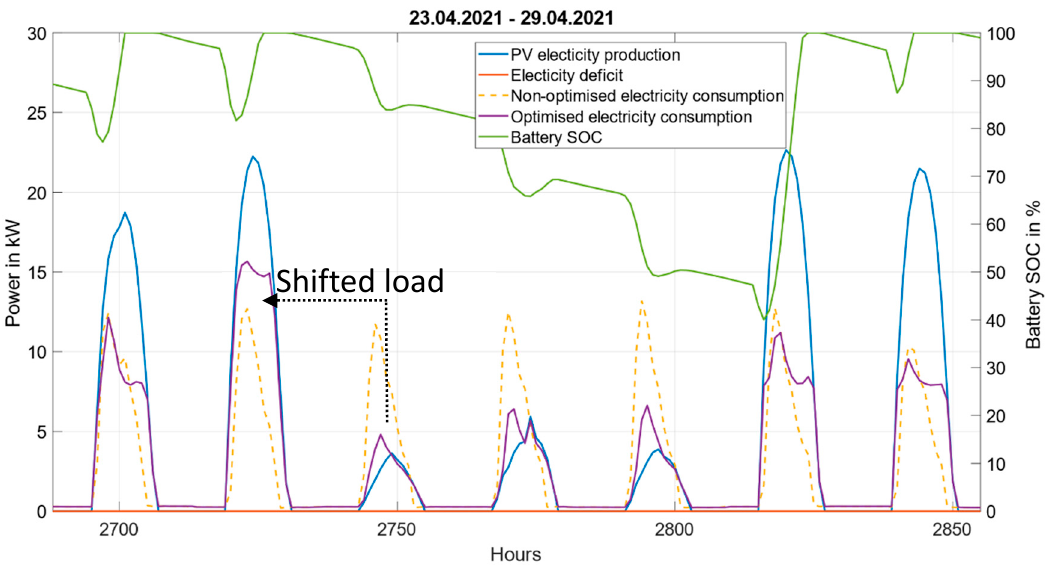
Figure 24. A week in April after load shifting and optimization.